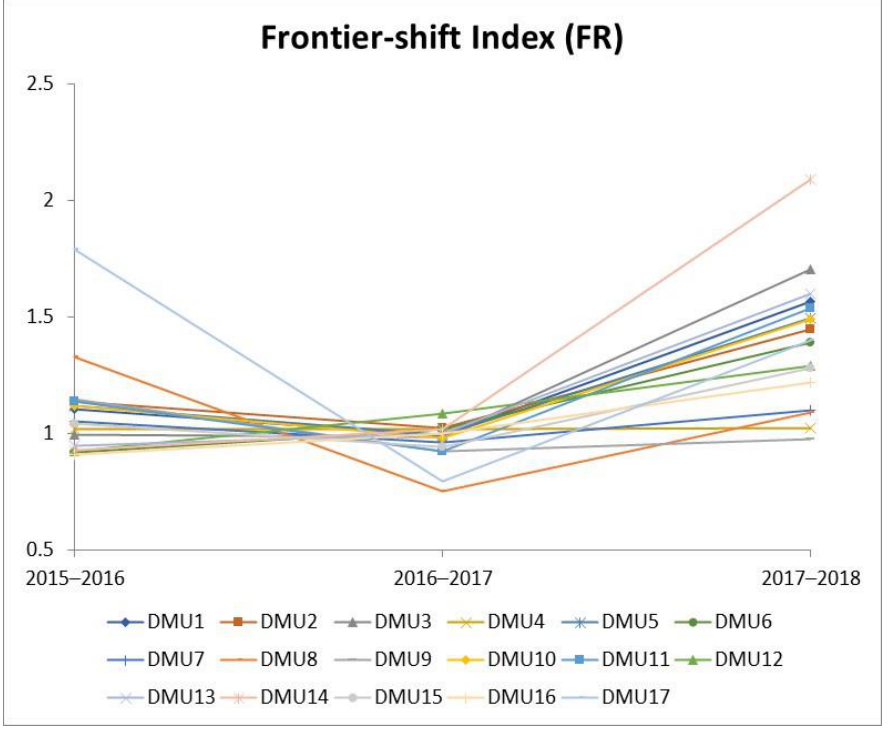
Figure 4. Technological efficiency frontiers.